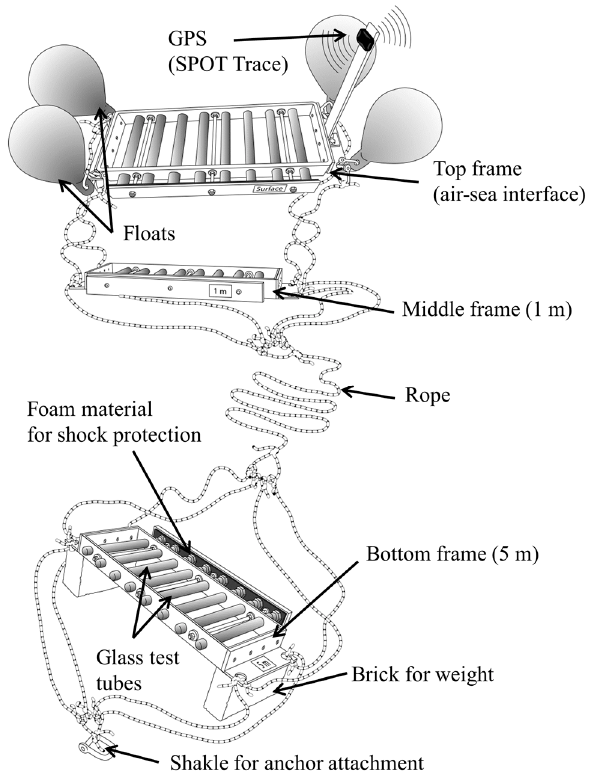
Figure 1. Scheme of the Surface In Situ Incubator (SISI).